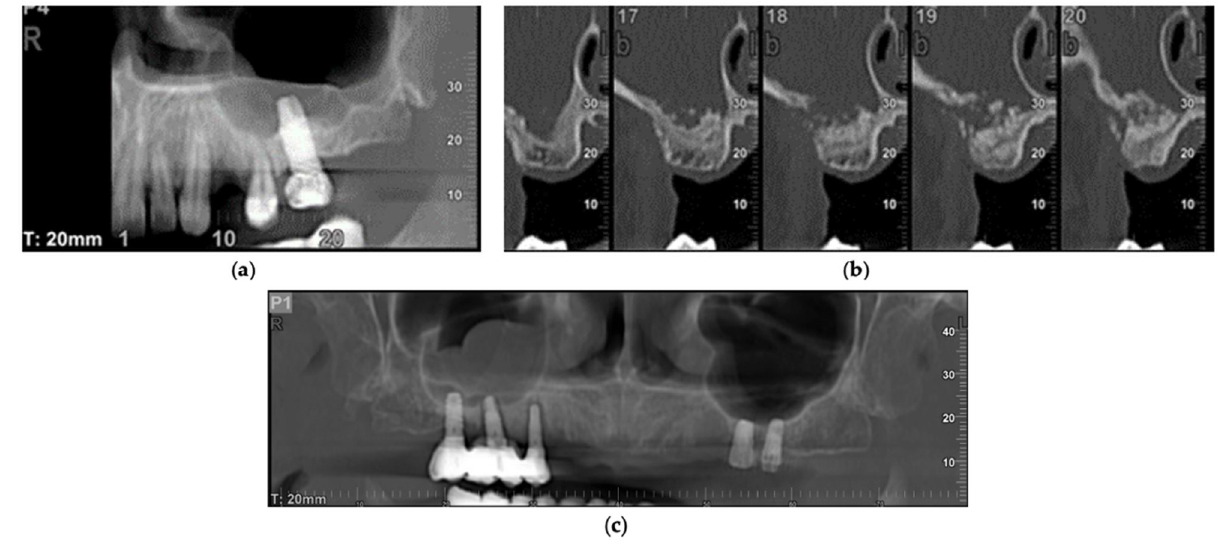
Figure 2. Implant treatments triggering sinus thickening: ( a ) implant exceeding the floor of the maxillary sinus; ( b ) sinus elevation failure; ( c ) peri-implantitis in the right maxillary sinus.